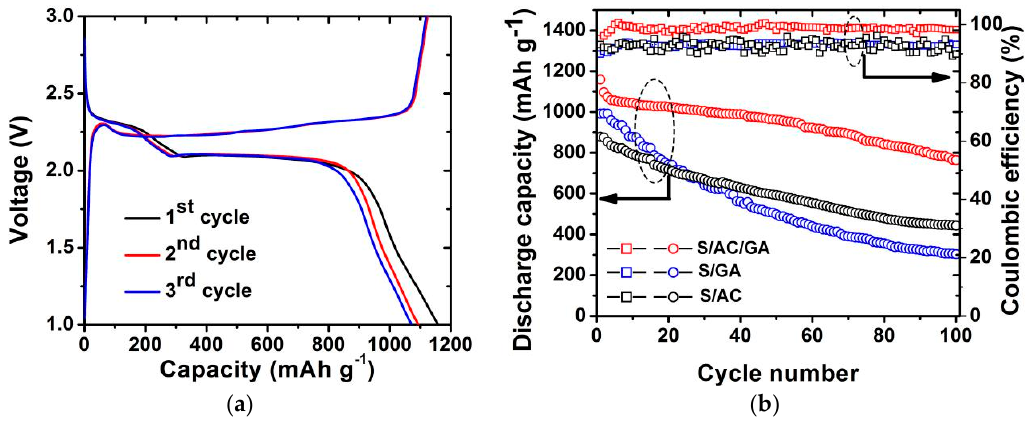
Figure 8. ( a ) Discharge/charge profiles of cell with S/AC/GA composite electrode at 0.1 C; ( b ) Cycle performance of S/AC, S/GA, and S/AC/GA composite electrodes within a potential range from 1.0 V to 3.0 V at a current rate of 0.1 C.